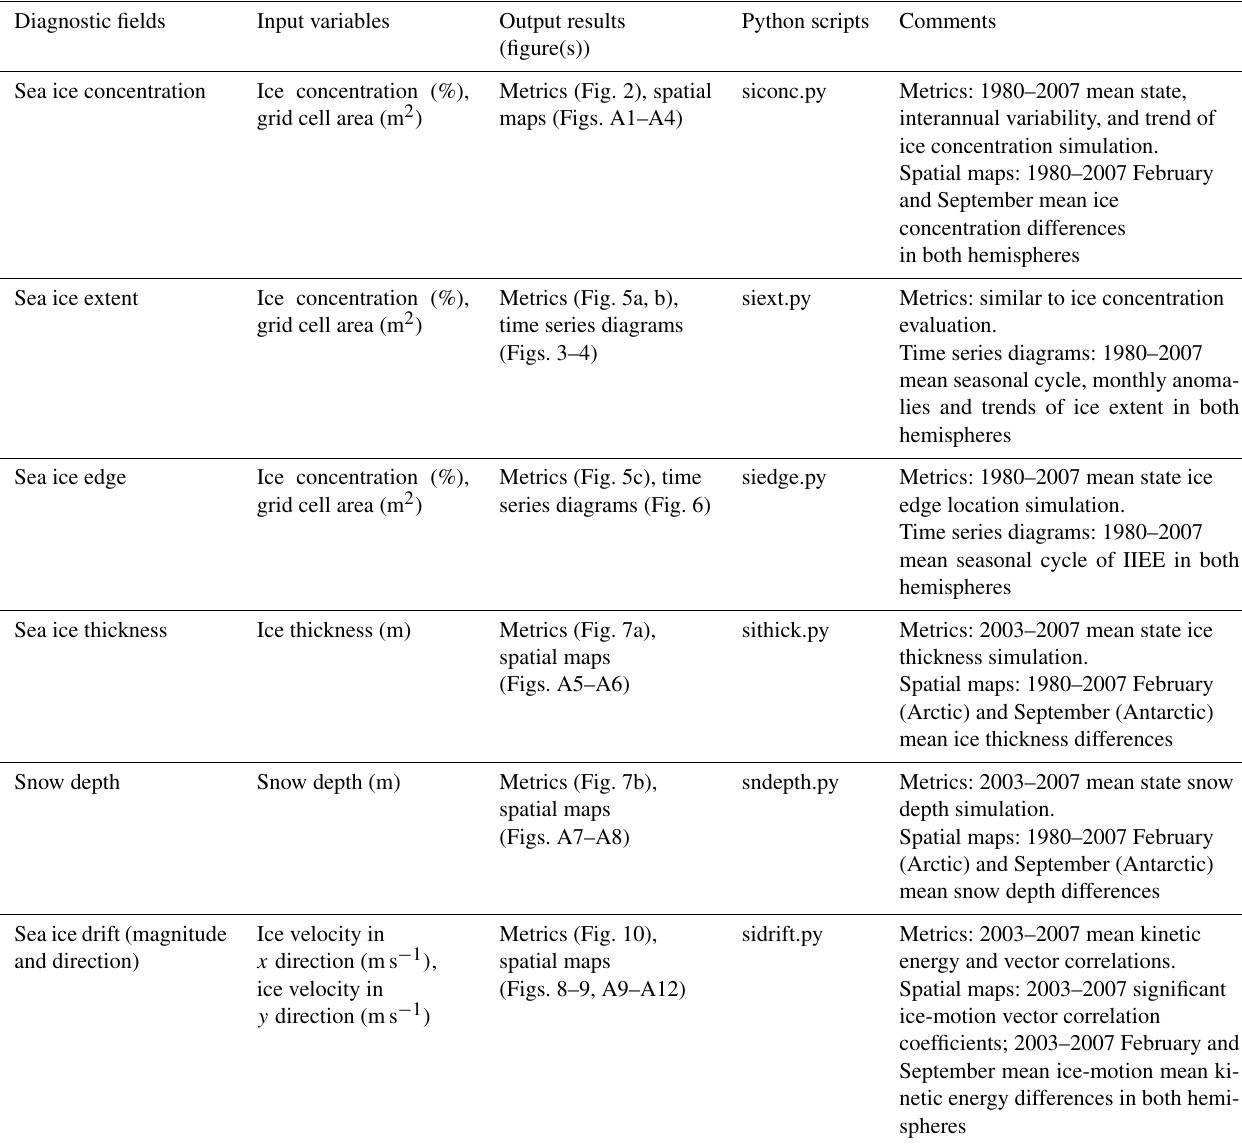
Table 1. Overview of the diagnostic fields along with input variables, output results and corresponding figures in this paper, Python scripts in the repository, and